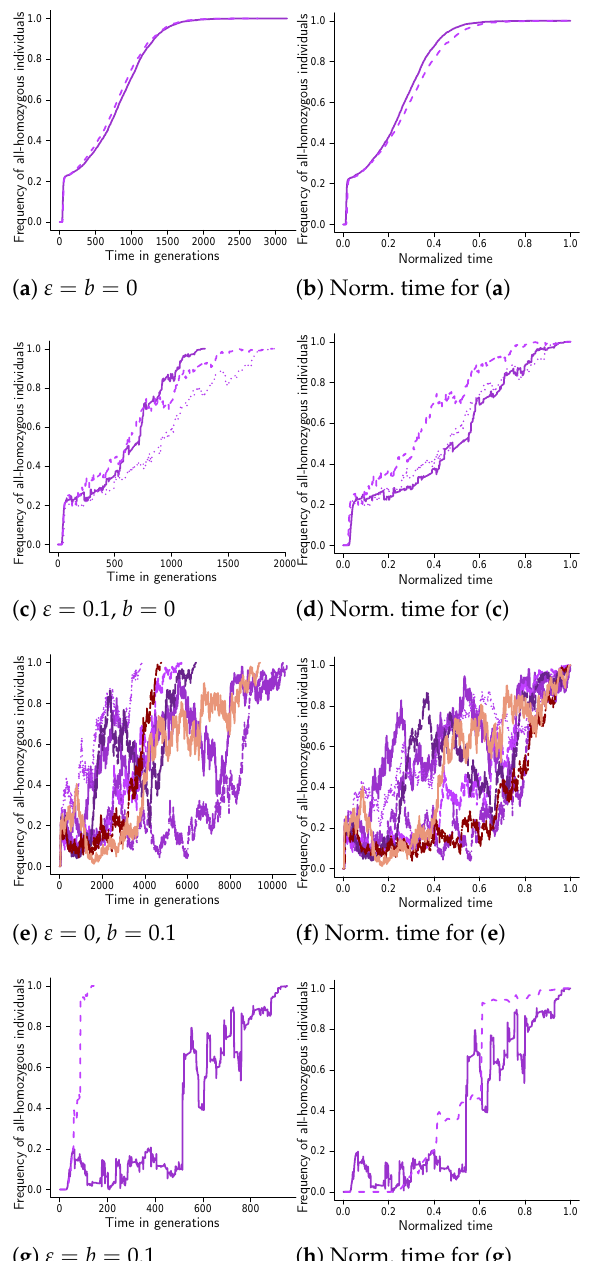
Figure A8. Three sites with weight function as in Equation (A4). Examples of fixation trajectories at three sites with weight function as given by Equation (A4) ; carrying capacity C = 10 6 , cutoff u ( N ) = C , probability of recombination r = 0.25 between adjacent sites, α 1 = 0.75, α 2 = 3, ε (see Equation (7)) and probability of a bottleneck b as shown, strength of selection s = 0.01 and bottleneck B = 10 3 . In ( a , c ), trajectories are from ten experiments; trajectories in ( e , g ) are from 10 2 experiments. Each trajectory traces, as a function of time, the number of diploid individuals homozygous for the fit type at all sites relative to the population size (the number of diploid individuals). The panels on the right ( b , d , f , h ) show the corresponding excursions from the left panels ( a , c , e , g ), where the time to fixation for each excursion is normalized by the time to fixation for the excursion. The scale of the abscissa (time axis) may vary between panels; in each panel, the trajectories were all obtained under identical